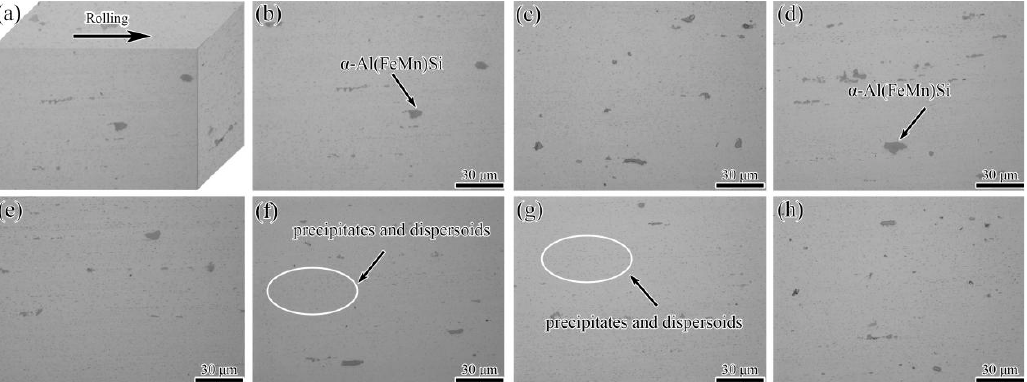
Figure 3. Optical microscopy (OM) images of the annealed 7005 aluminum alloy plate ( b ) before and ( c – h ) after different pre-tensile deformations (3%, 5%, 8%, 12%, 16%, and 20%, respectively, along the longitudinal section; non-etched), ( a ) shows a 3D diagram of the undeformed sample.